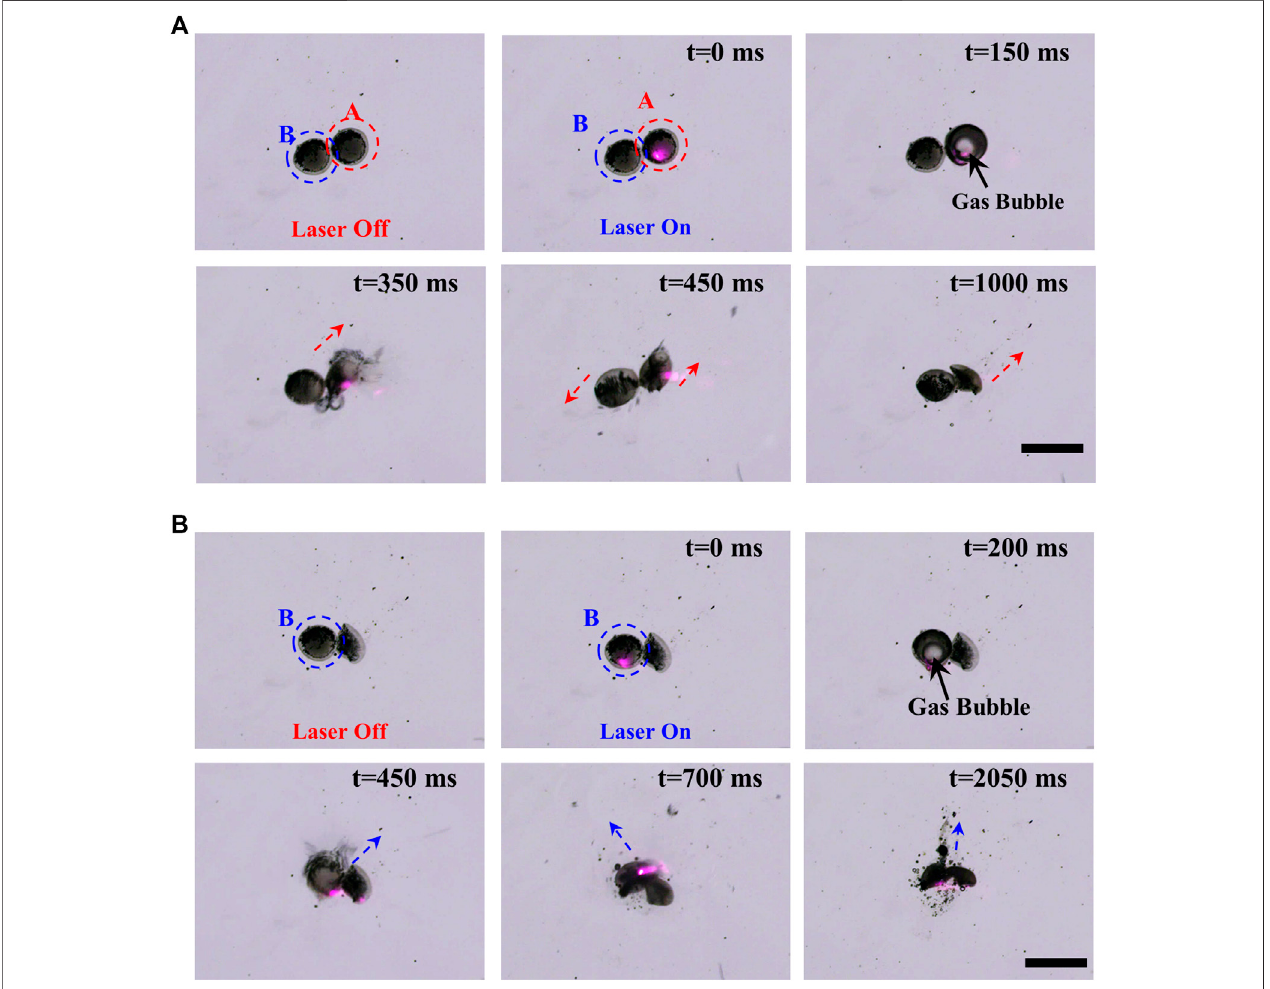
FIGURE 7 | Sequential laser activation of PMHMs. (A) NIR laser activation process of the fi rst PMHM at different times. (B) NIR laser activation process of the second PMHM at different times. Scale bar: 500 μ m.